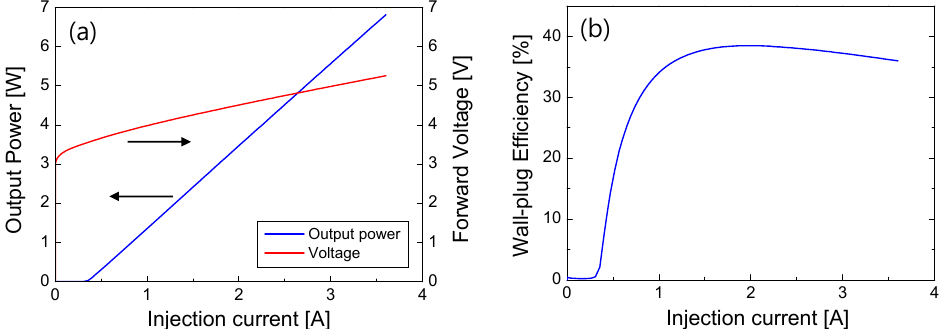
Figure 3. ( a ) Output power versus current ( L–I ) and forward voltage versus current ( V–I ) curves for the simulated reference LD structure. ( b ) Wall-plug efficiency (WPE) as a function of injection current for the simulated reference LD.